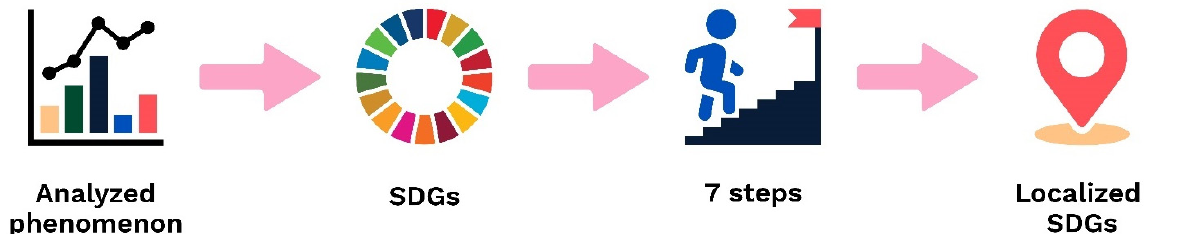
Figure 2. Abstract-level description of the SST process. Analysed phenomenon goes through a sensemaking process where it is reflected in relation to SDGs through a sensemaking process. In this section, we present the SDG Sensemaking tool, explaining each explicit step separately. The estimated time taken per step is based on learnings from pilot workshops, and represents a median of experiments. Thus, it is more indicative than exact or binding.